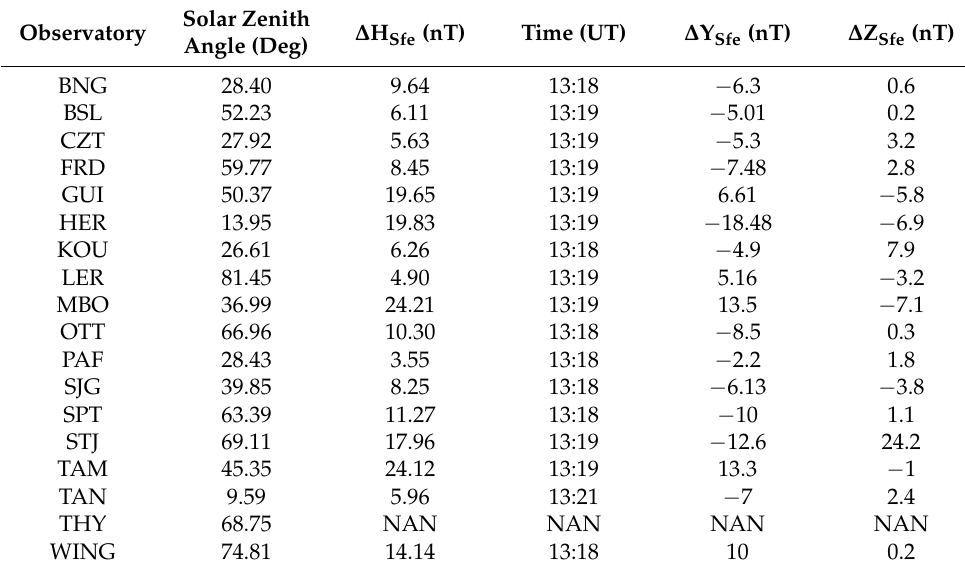
Table 3. The magnetic response to the X2.6 solar flare of 27 November 1997.